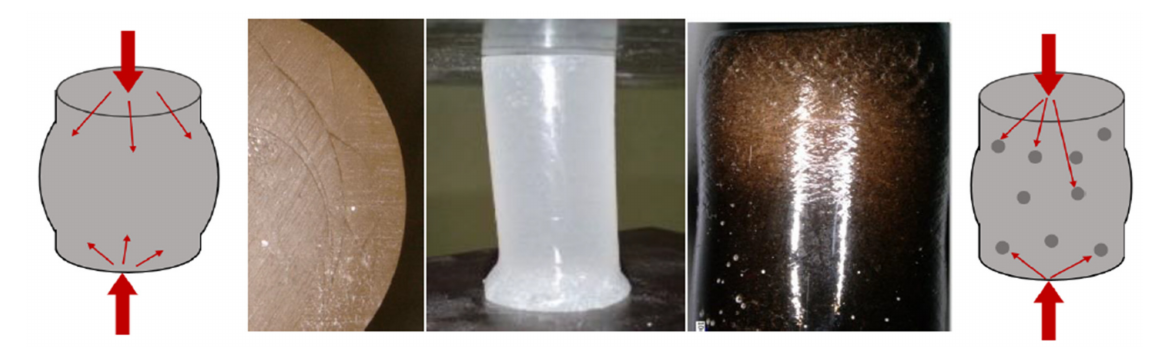
Figure 15. Samples subjected to a compression test.